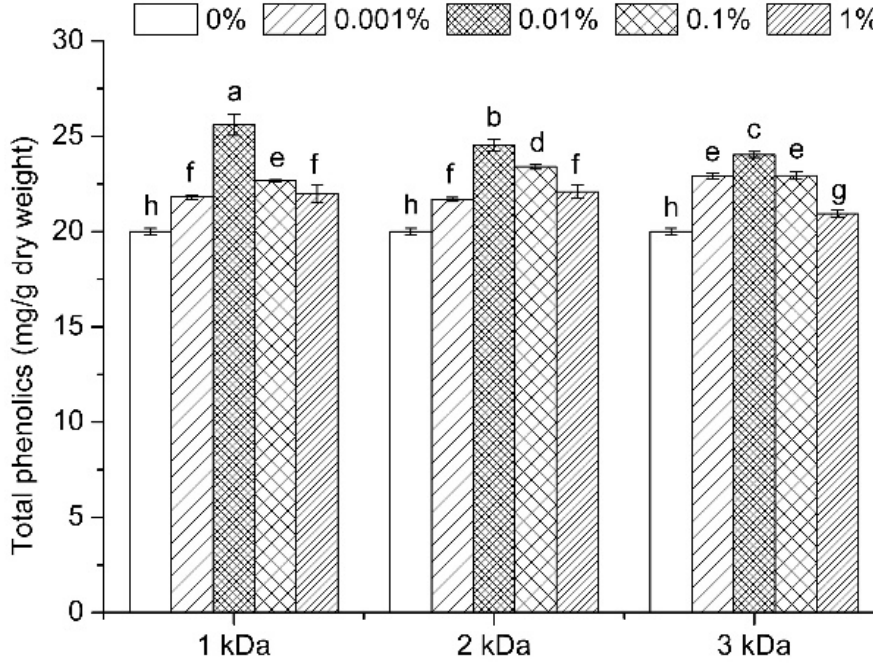
Figure 2. Total phenolics content of soybean sprouts under different chitooligosaccharide treatments. The treatments were conducted with chitooligosaccharides of three molecular weights (1, 2, and 3 kDa) at four different concentrations (0.001 to 1%). The control treatment (0%) included the same solutions without chitooligosaccharides. Vertical bars represent the standard error of three replicates. Different letters indicate statistically significant difference ( p < 0.05). 3.3. Total Flavonoid Content Germination could increase the flavonoid content, which might be owing to the acti- vation of enzymes involved in the biosynthesis of flavonoids from large molecular weight polyphenols such as tannins [26]. Flavonoids contain a diverse group of phytochemicals with antioxidant and anticancer activity, and they have been detected in fruits, vegetables,